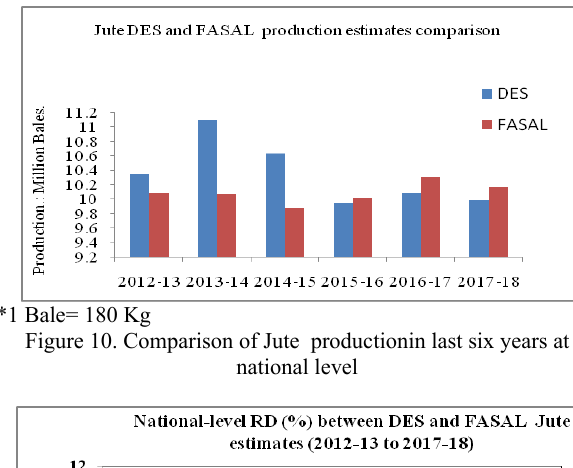
Figure 9.Comparison of Jute acreage in last six years at National level